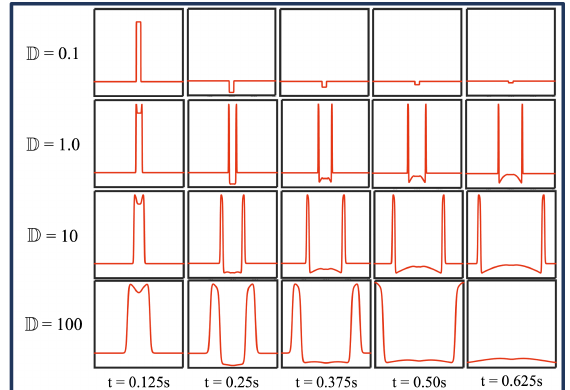
Fig. 8: Different traveling wave